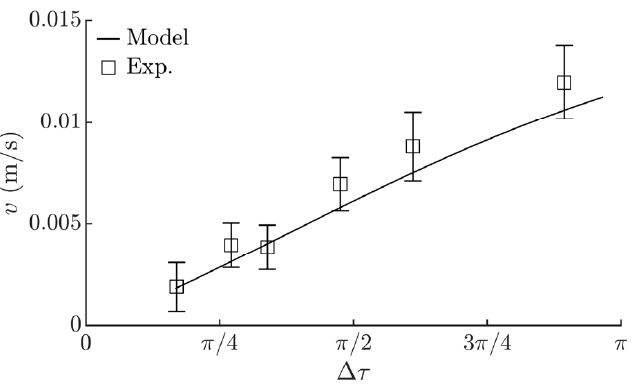
Figure 10. Experimental and modeling results of the mean displacement velocity depending on Δ τ when μ 1 = 0.1, μ 2 = μ 1 /8, g = 9.81 m/s 2 , A e = 0.28 mm, ω = 62.8 rad/s, ε = π /2, ϕ = 0.